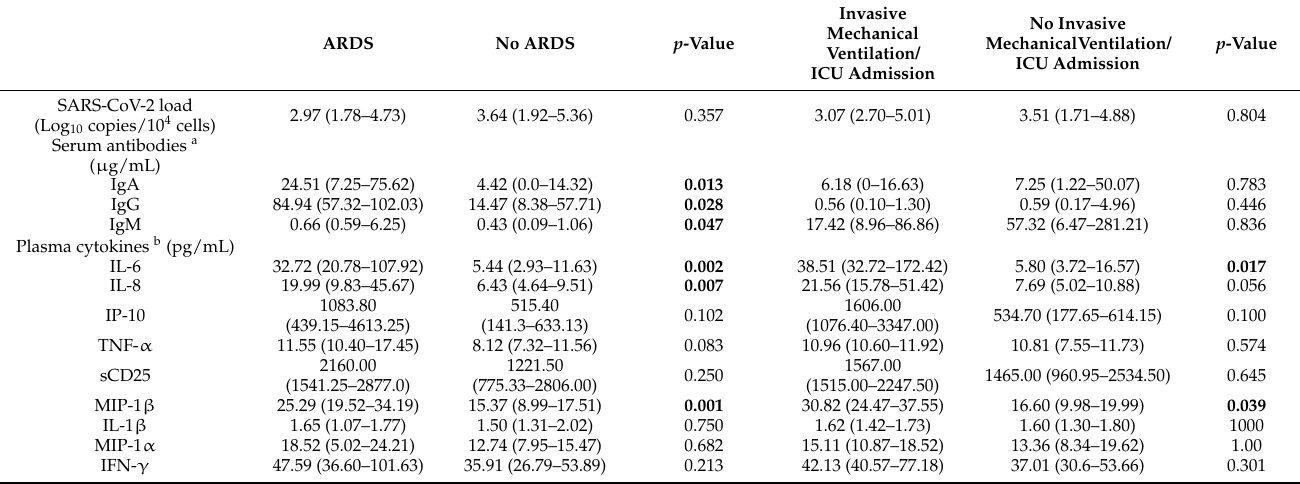
Table 3. Biomarkers of severe